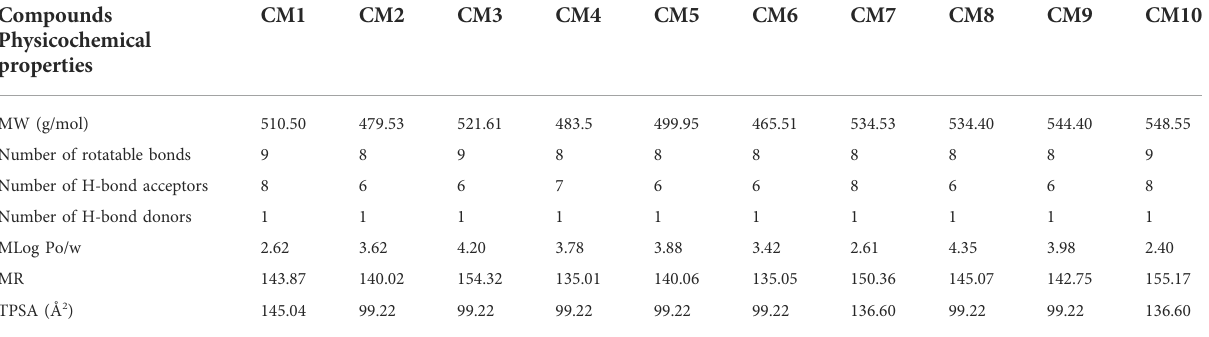
TABLE 6 Physicochemical properties and drug-likeness prediction of designed compounds. Compounds Physicochemical